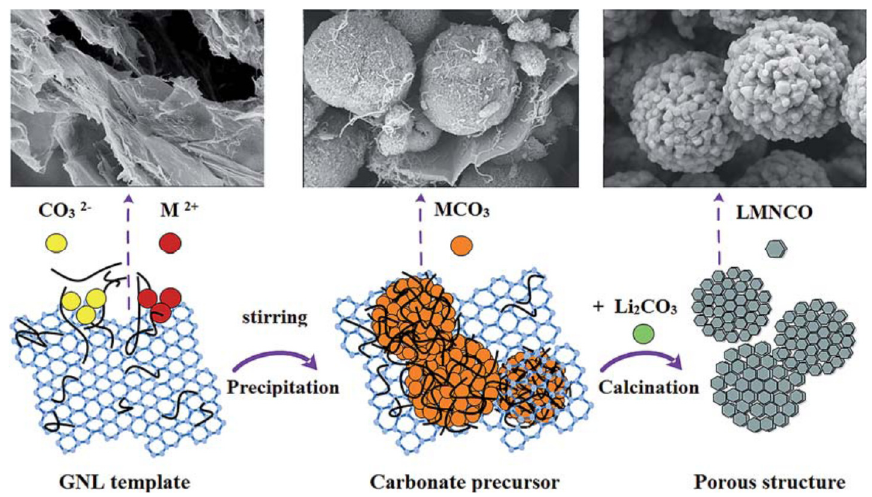
Figure 7. Formation mechanism of the porous graphene and carbon nanotube conductive liquid- Li 1.2 Mn 0.534 Ni 0.133 Co 0.133 O 2 cathode. Reproduced with permission from [40]. American Chemical Society, 2015.